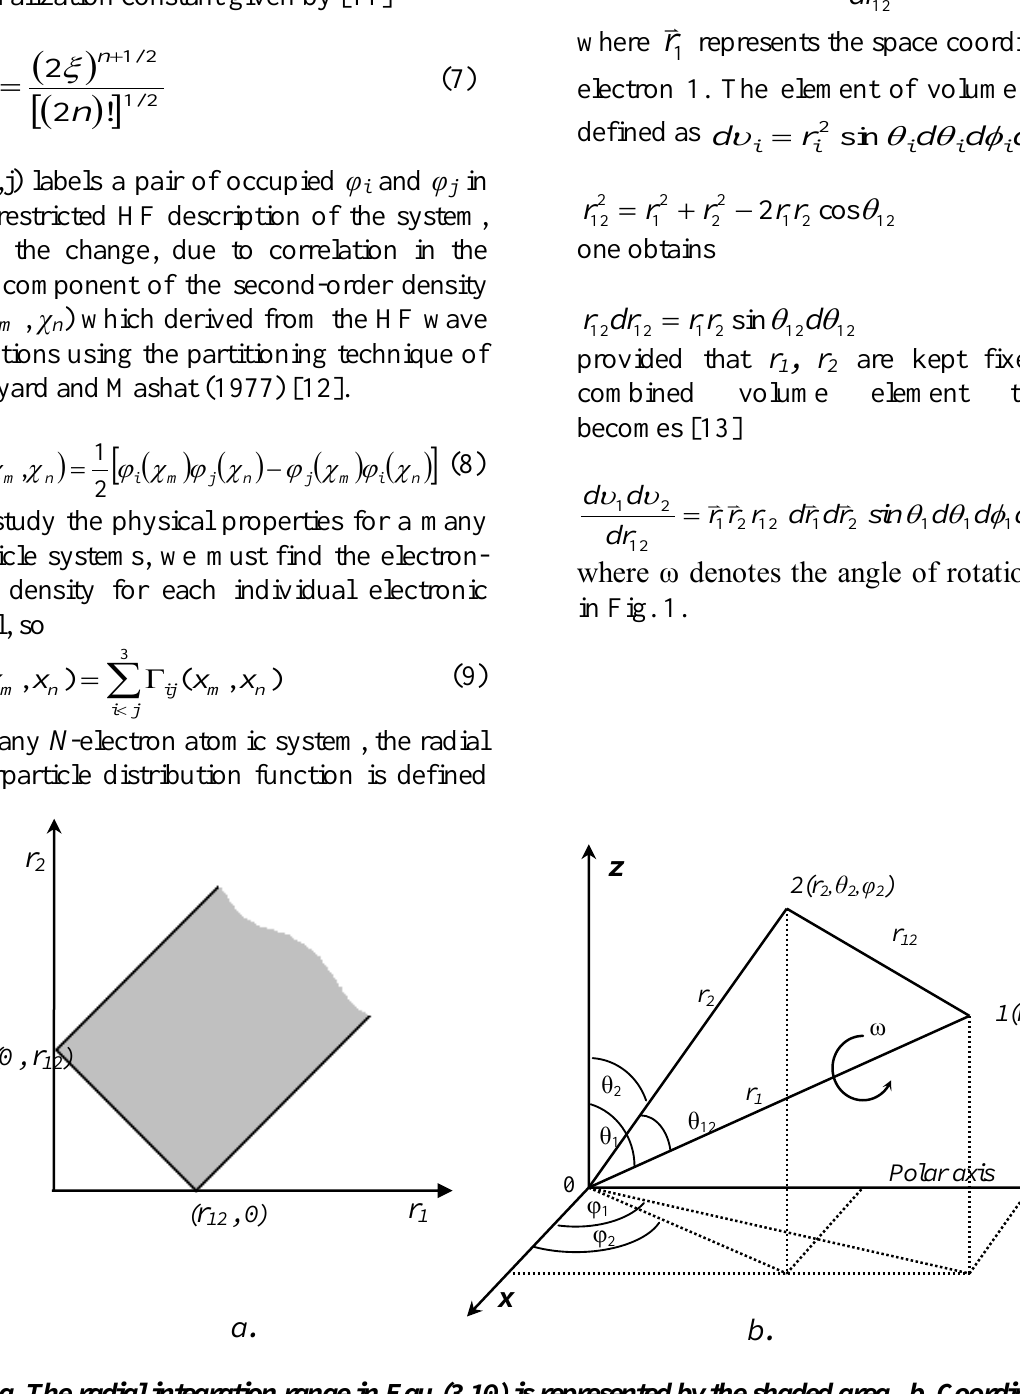
). Here, r , r are position vectors for electrons 1 and 2 relative to the origin 12 1 2 point